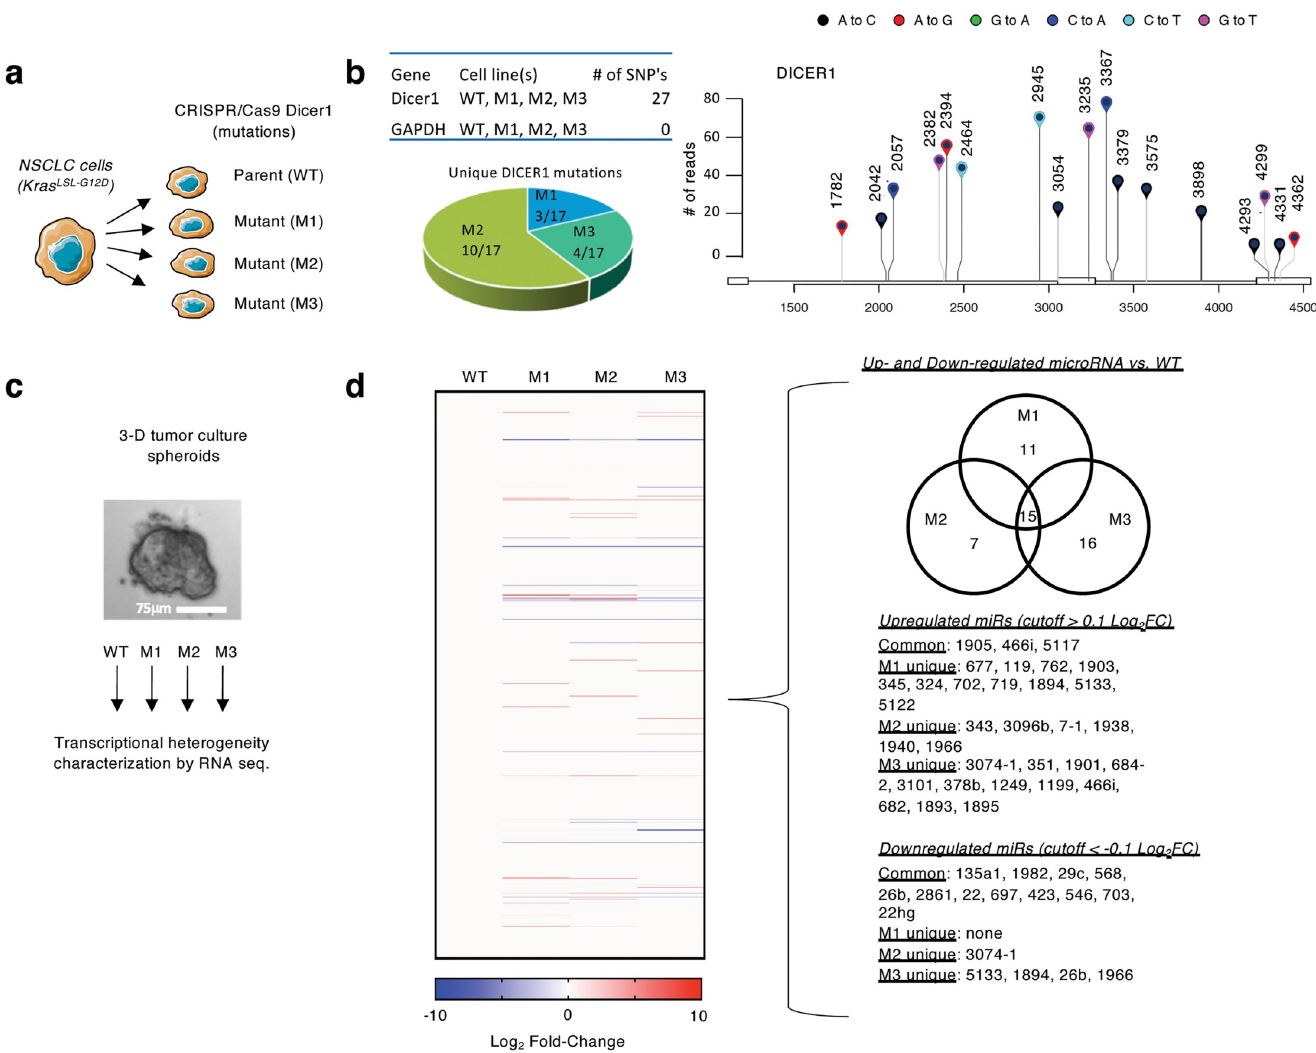
Fig 1. Characterizing phenotypic heterogeneity in Dicer1 engineered NSCLC cells. a ) Murine-derived non-small cell lung cancer (NSCLC) cells were engineered with mutant Dicer1 clones using the CRISPR/Cas9 toolkit. b ) Lollipop graph quantifies SNPs in the mutant vs. WT cells including location and mutation annotation. Total number of normalized SNP counts is shown on the Y-axis. Table shows number of SNP identified in each cell line, GAPDH was used as a control to validate SNP identification algorithm. c ) 3D cultured cells were characterized for transcriptional and therapeutic sensitivity heterogeneity. d ) (left) Heat map shows differential expression pattern of miRNA compared to WT; (right) List of unique and shared differentially expressed miRNA.